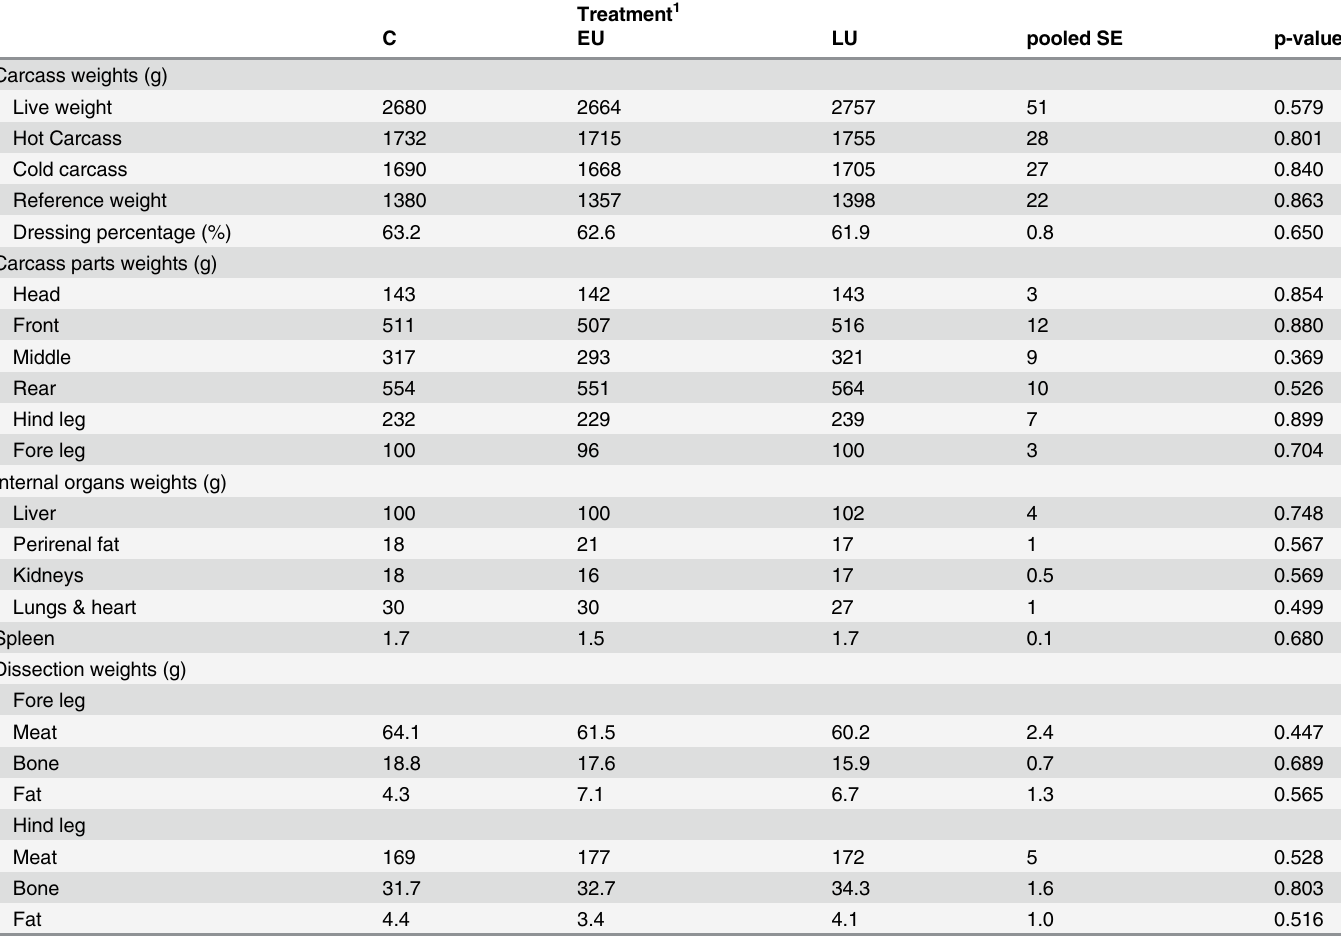
Table 3. Effect of gestational maternal undernutrition on carcass quality parameters of rabbit offsprings (n =